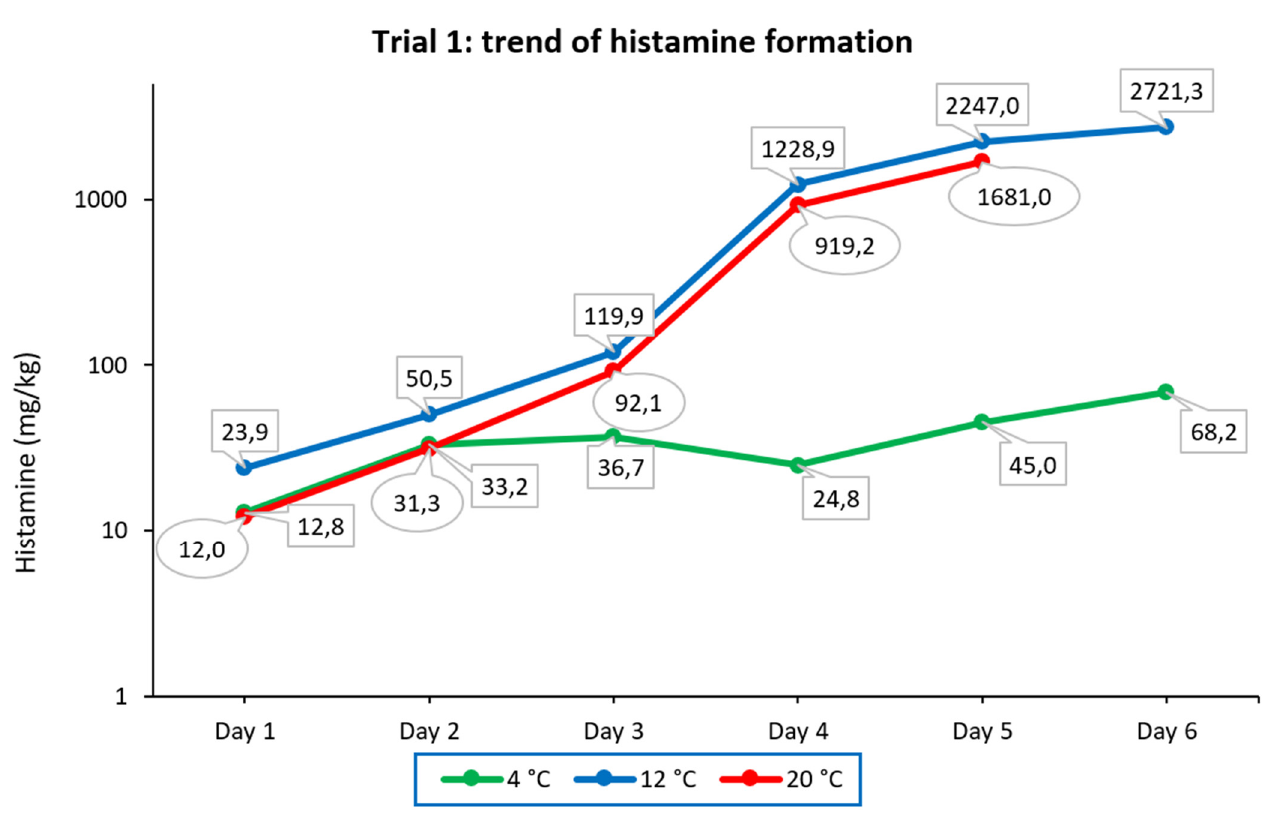
Figure 3. Trend of histamine formation over six consecutive days in fresh tuna samples grafted with tuna muscle naturally incurred with histamine and stored under different temperature conditions (trial 1). The ordinate is scaled logarithmically.